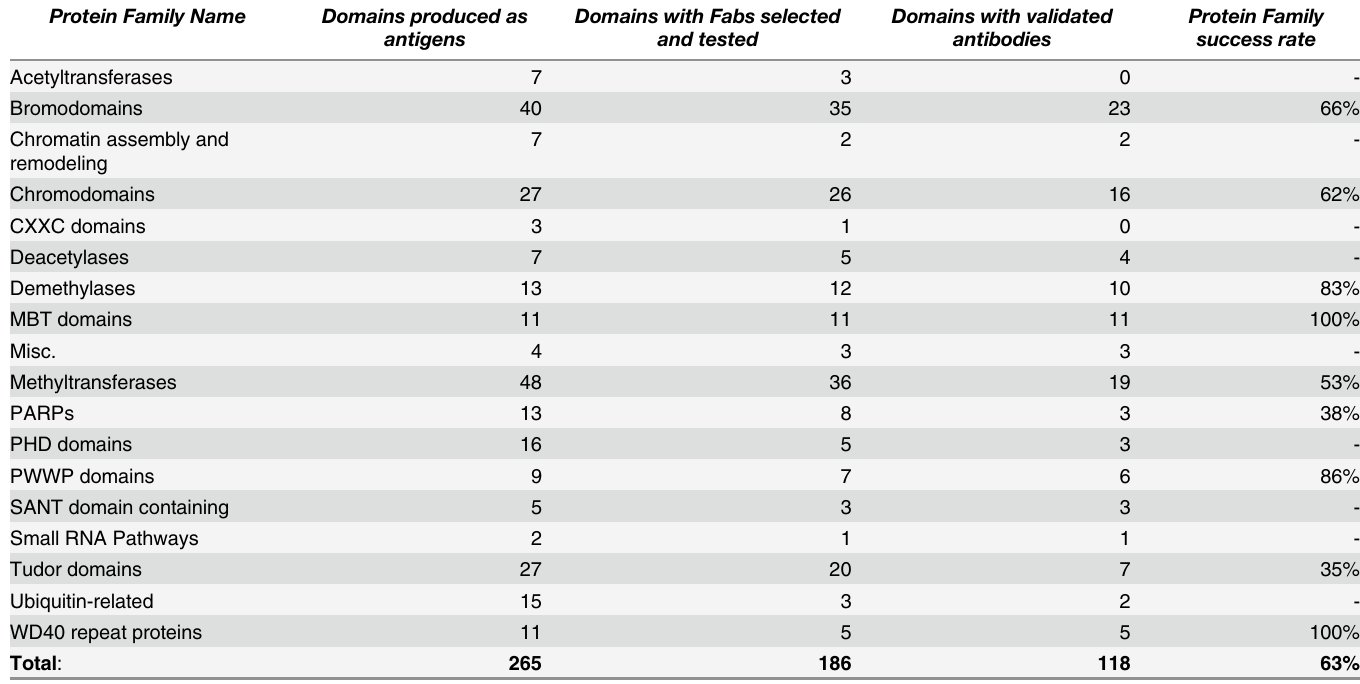
Table 1. Overview of targets and their success